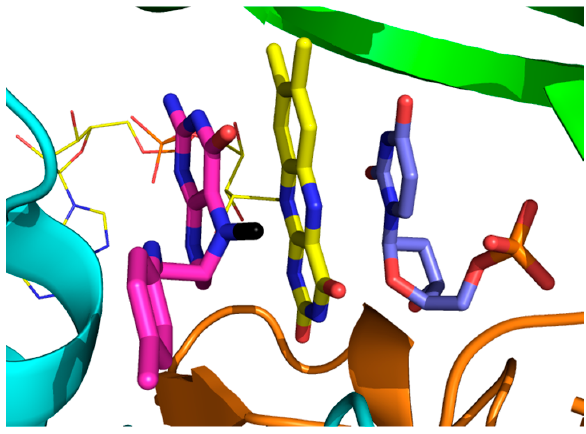
Figure 1. Structure of the active site of FDTS from T. maritima with folinic acid (magenta), FAD (yellow), and dUMP (blue) (PDB ID 4GTA) [20]. The three monomers that combine this active site are in green, light blue and orange, and the carbon that is to be transferred is marked in black.